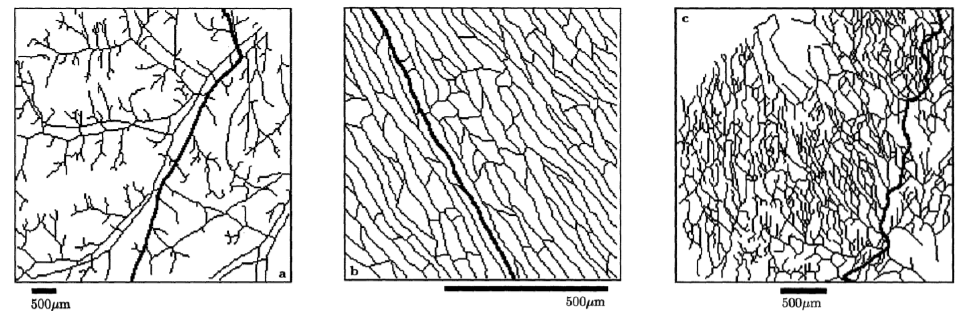
Figure 1. Representative skeletonized images of three types of vascular networks. Bolded lines represent the minimum path for each network. ( a ) Healthy subcutaneous arteriovenous network. ( b ) Healthy subcutaneous capillary network. ( c ) Tumour network. Note: Figure reproduced from [24] with